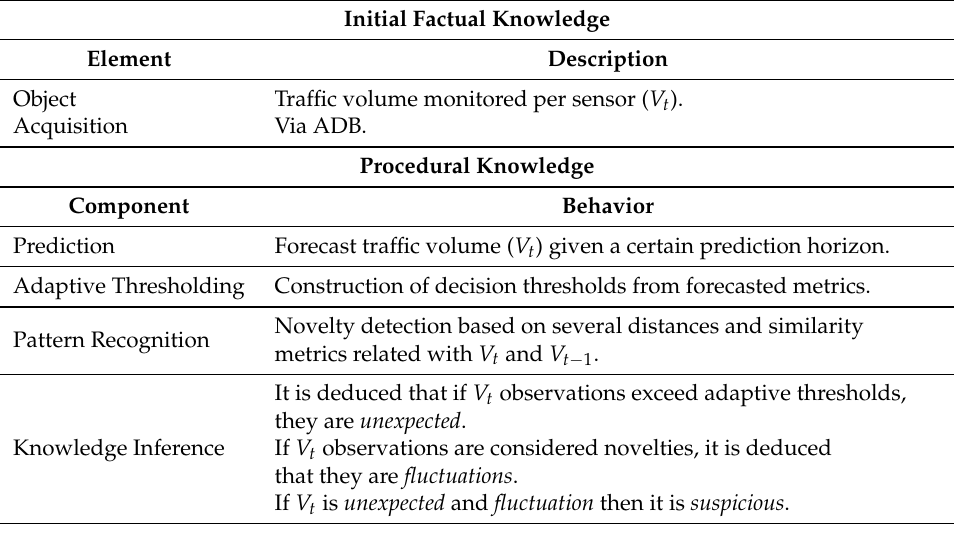
Table 1. Summary of the instantiated initial knowledge and